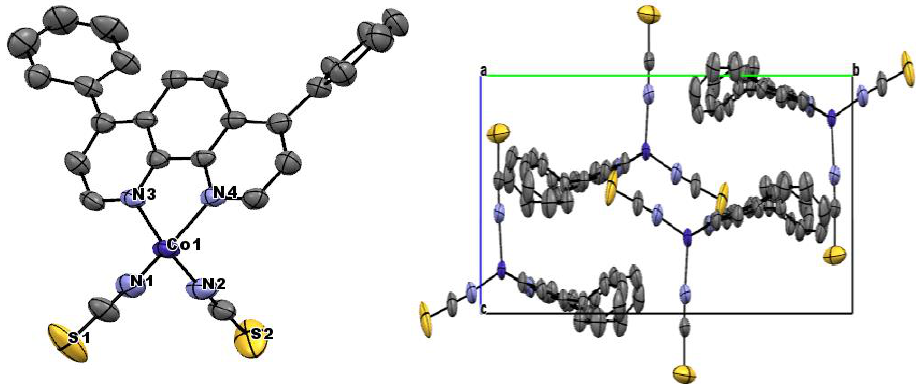
Figure 1. Crystal structure diagram of complex 1 and packing arrangement.